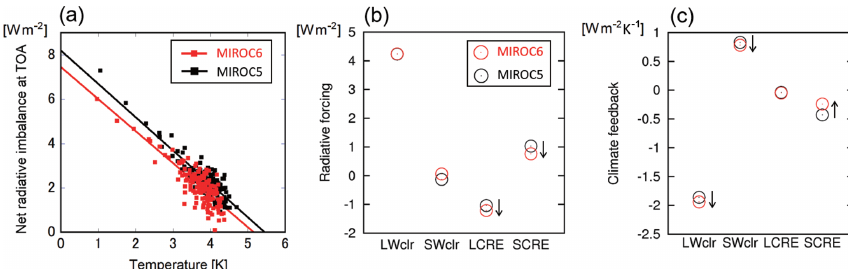
Figure 30. (a) Global mean net radiative imbalance at the TOA plotted against the global mean SAT increase. Data from the first 150 years after the abrupt CO 2 quadrupling are used. (b) 2 × CO 2 radiative forcing estimated by regressing four components of TOA radiation against the global mean SAT, following Gregory and Webb (2008). (c) Same as (b) but for climate feedback. In (b, c) LWclr (SWclr) and LCRE (SCRE) denote a clear-sky longwave (shortwave) component and a longwave (shortwave) cloud component, respectively. The arrows in (b) and (c) indicate that the results of MIROC6 are different from MIROC5 at the 5% level.